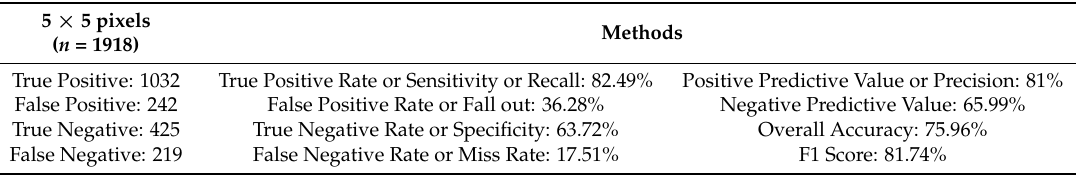
Table 6. Error matrix of rice fields with flooding using the Start of Season (SOS) as an indicator for detecting disruptions in cropping schedules. SOS of the wet planting season 2013/2014 is compared to that of the long-term average